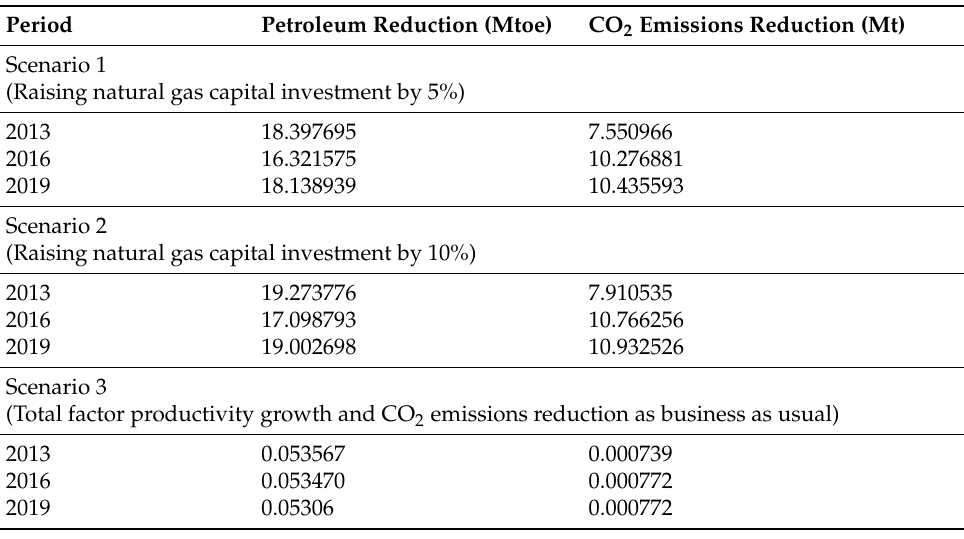
Table 5. Petroleum reduction and CO 2 Es mitigation